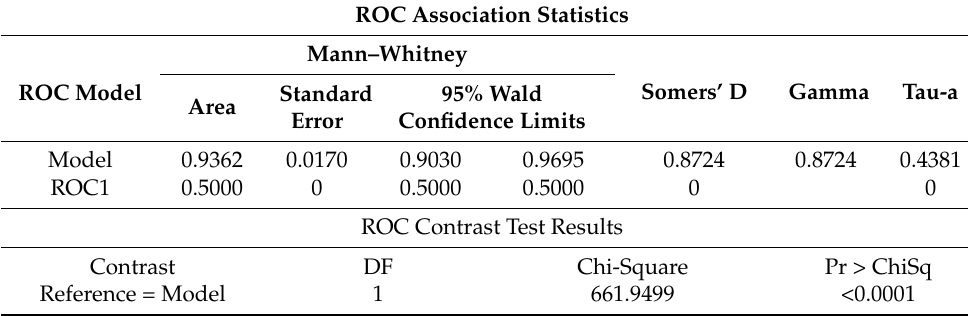
Table 4. AUC significance tests.